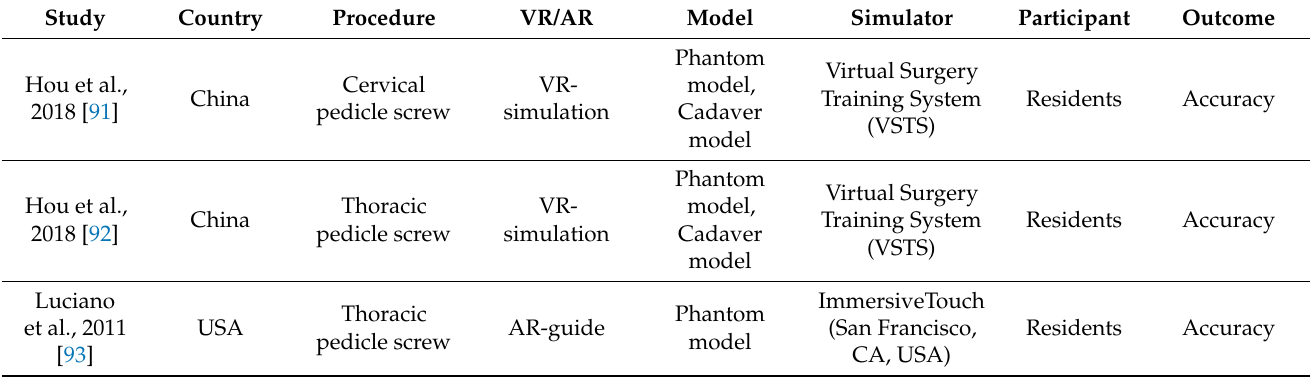
Table 1. A summary of surgical simulation with XR technology in spine